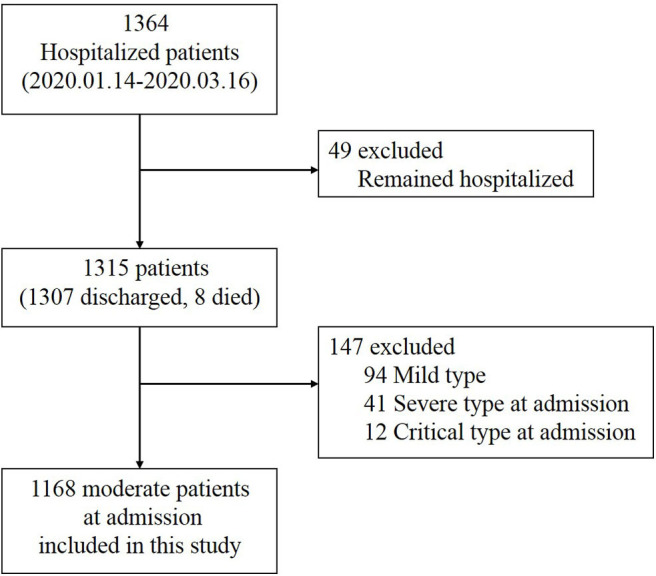
Selection of coronavirus disease 2019 (COVID-19) cases for inclusion in the study.